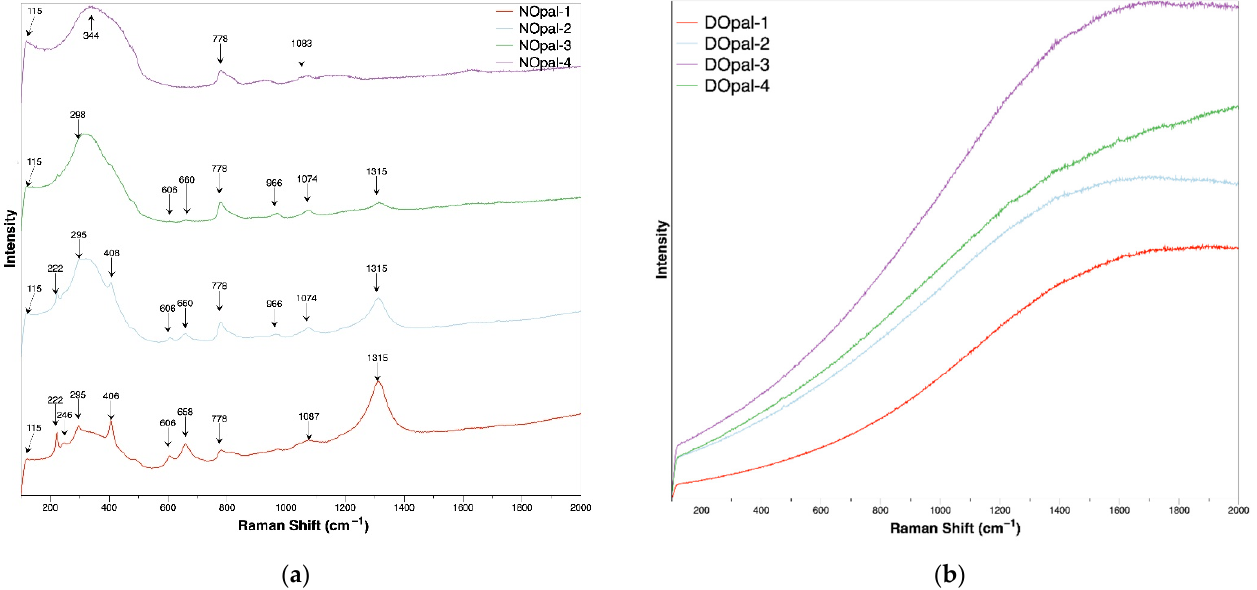
Figure 7. Raman spectra of samples with a 532 nm laser: ( a ) natural opals; ( b ) dyed opals.